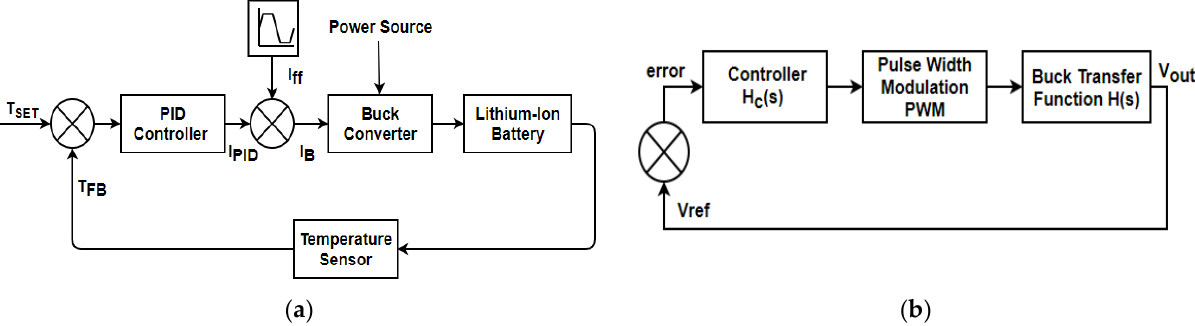
Figure 1. ( a ) Block diagram depicting CT–CV charging technique; ( b ) block diagram of voltage-mode control in buck converter.